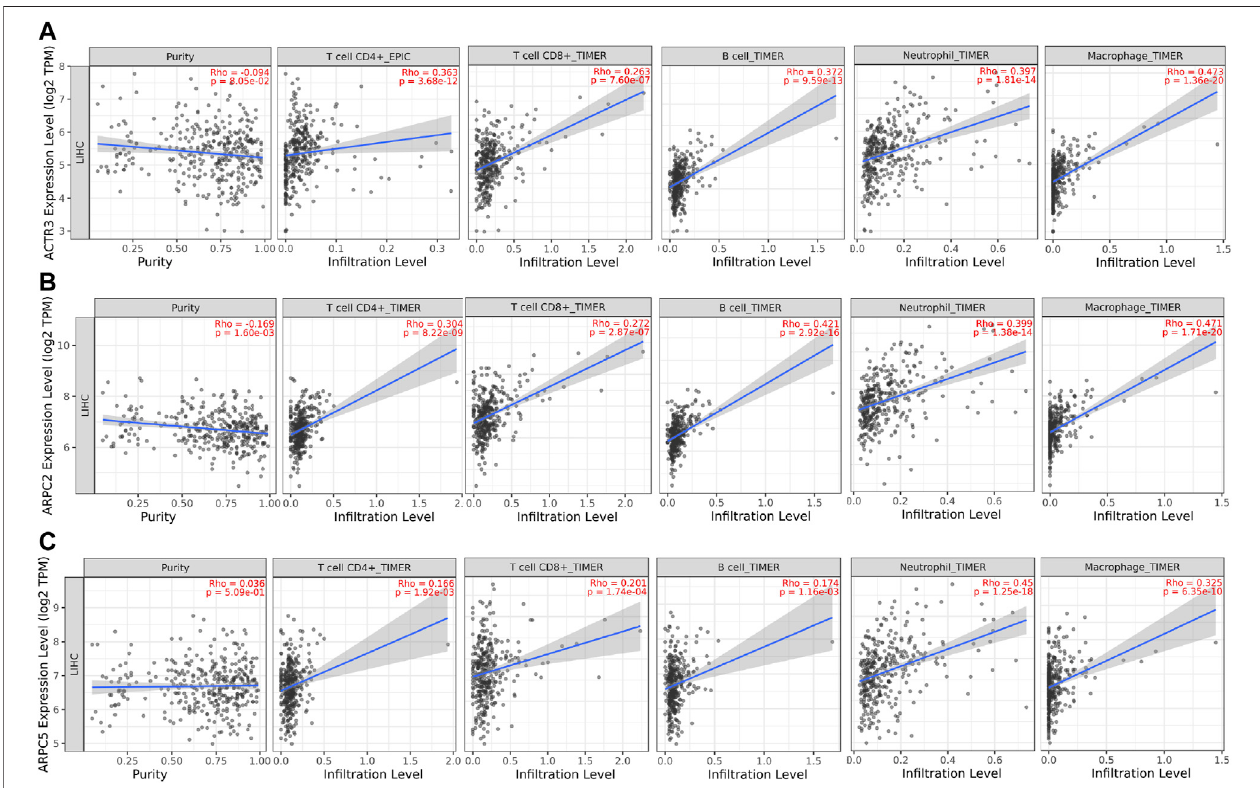
FIGURE12| Correlationanalysisbetweentumor-in fi ltratingimmunecells(TIICs:CD4+Tcells,CD8 + Tcells,Bcells,neutrophils,andmacrophages)andsigni fi cant prognostic Arp2/3 members in HCC. (A) ACTR3; (B) ARPC2; and (C) ARPC5. Tumor purity is shown in the panels on the